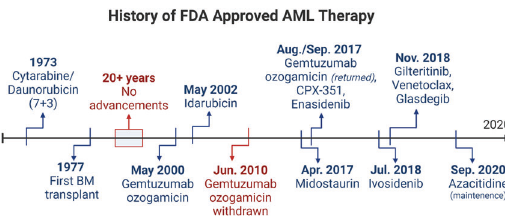
Fig. 1 History of AML therapies. Timeline of approved clinical therapies in the United States for the treatment of